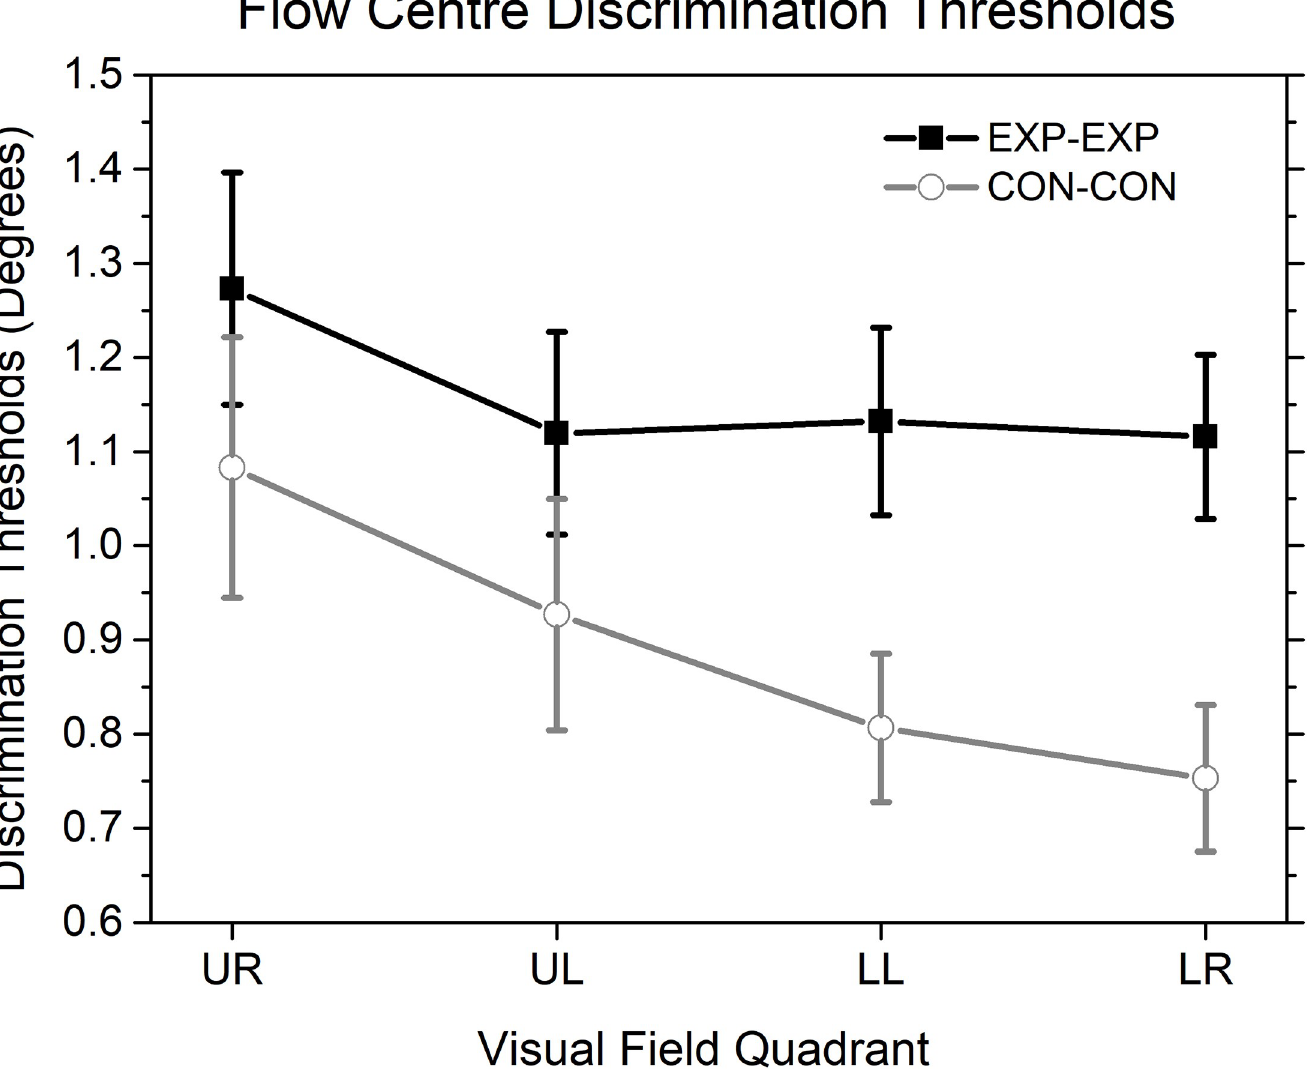
Fig 5. Mean thresholds for discriminating between the positions of the centres of two optic flow patterns in each visual quadrant in the two sub-conditions (EXP-EXP and CON-CON) of Experiment 2. UR: upper right; UL: upper left; LL: lower left; LR: lower right. Vertical error bars represent standard errors. The other details are as in Fig